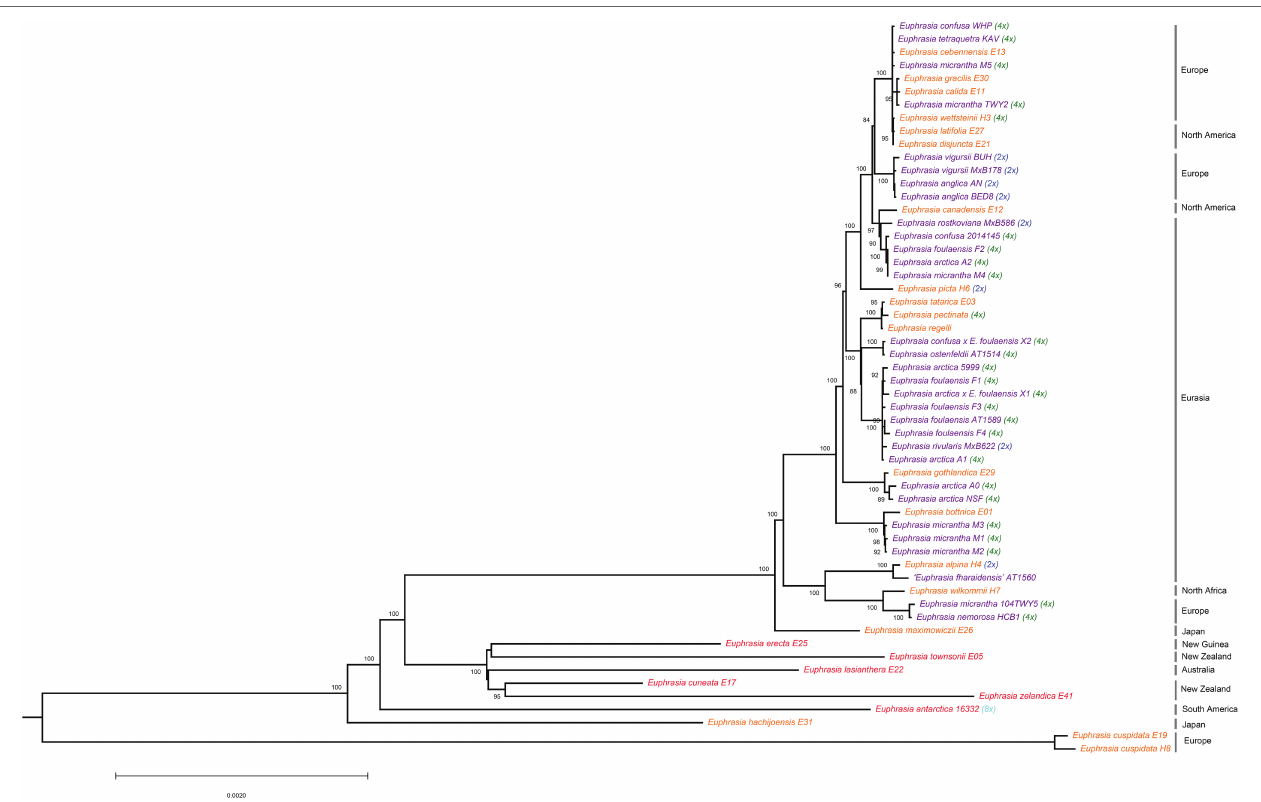
FIGURE 1 | Phylogenetic relationships inferred from plastid genomes for global Euphrasia species. Phylogeny constructed based on an alignment of 157,898 sites, using a maximum likelihood analysis implemented in IQTree 2. Branches labeled with bootstrap support values over 85%. Phylogeny rooted on Bartsia , which is removed here for better visualization. Tip labels are colored by geography, with red being Southern Hemisphere, purple being UK and orange being European and Asian samples. Tips are also labeled by known ploidy, including diploids (2x, blue), tetraploids (4x, green) and octoploids (8x, light